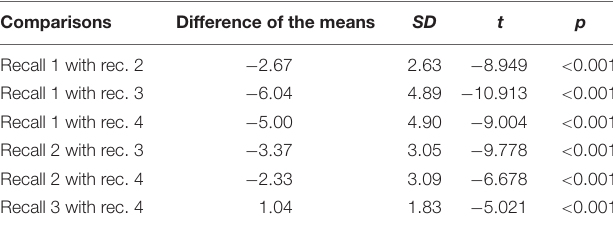
TABLE 2 | Follow-up analysis of the significant main effect of position with paired-samples t -tests. Comparisons Difference of the means SD t p Recall 1 with rec. 2 − 2 . 67 2.63 − 8 . 949 < 0.001 Recall 1 with rec.